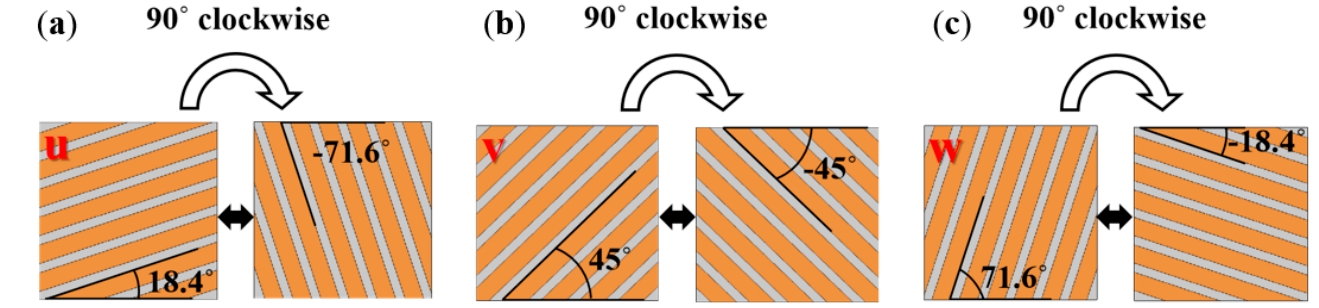
Figure 7. The square unit modules, with 18.4 ◦ ( a ), 45 ◦ ( b ), and 71.6 ◦ ( c ) angled stripe-shaped elements, constitute the convertible thermal meta-structural devices.